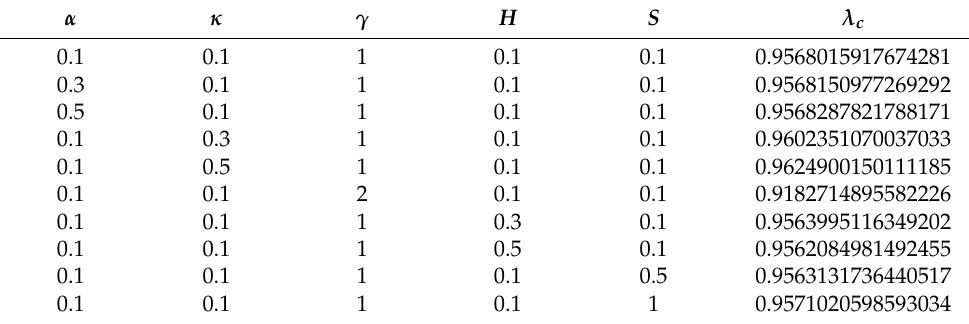
Table 4. Numerical result for stability analysis r = 1, ∈ =